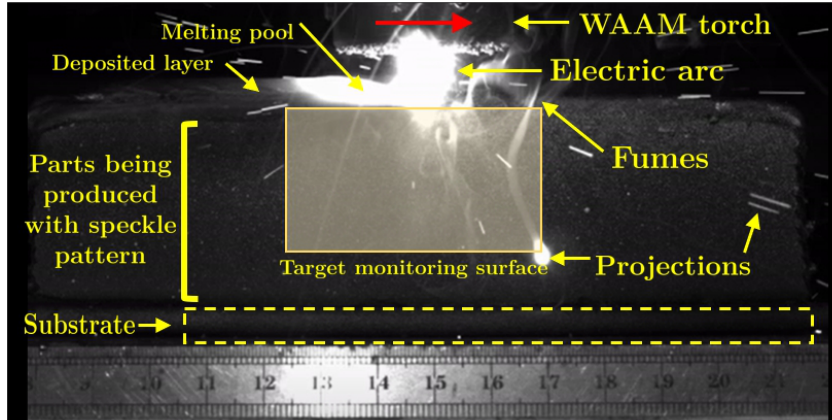
Figure 4. WAAM and DIC set-ups.